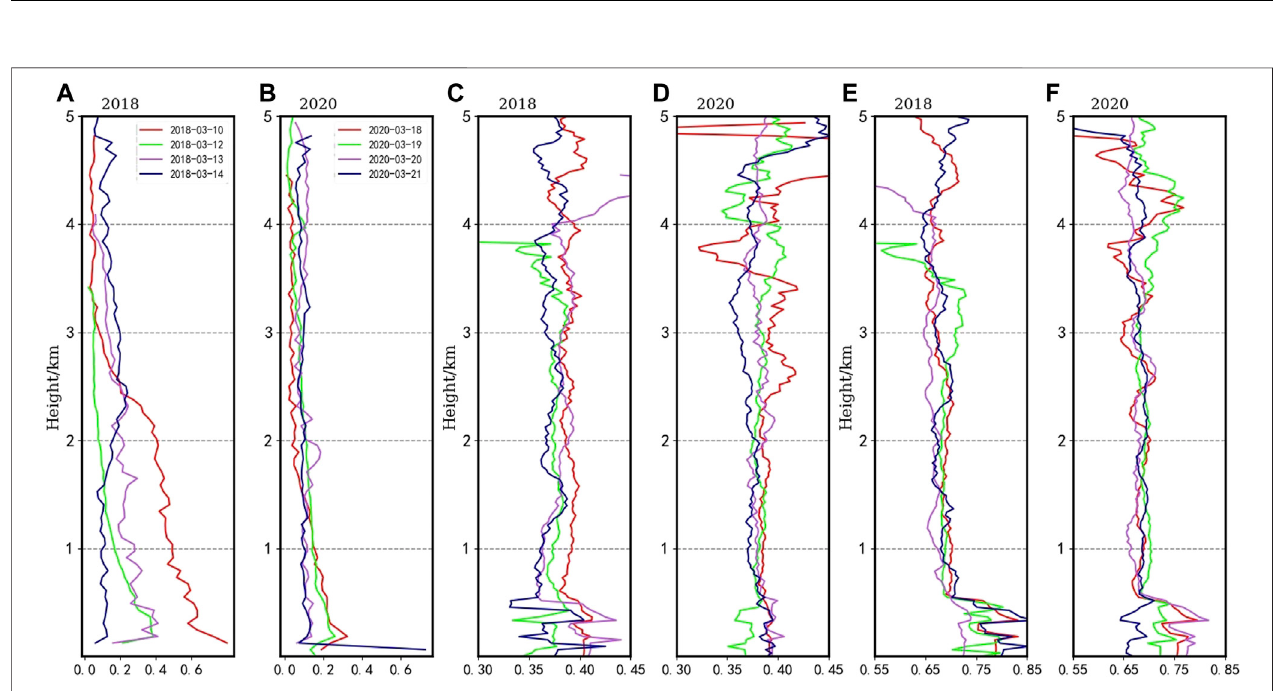
FIGURE 6 | Same in Figure 5 , while the aerosol includes only pure dust and polluted dust.